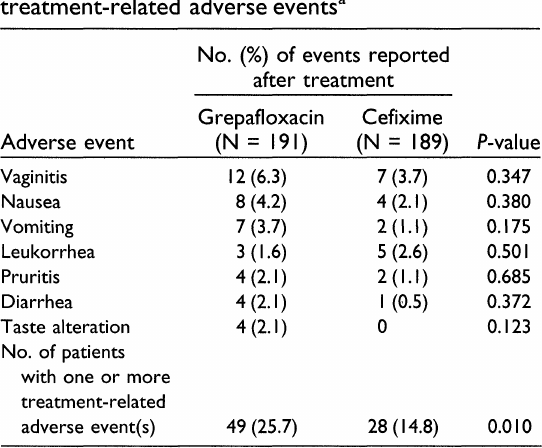
TABLE 3. Summary of most common treatment-related adverse events No. (%) of events reported after